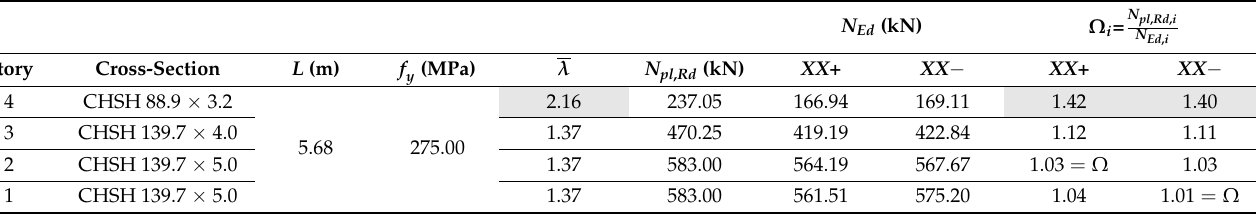
Table 1. Steel braces design results: q = 1.5 (DCL).